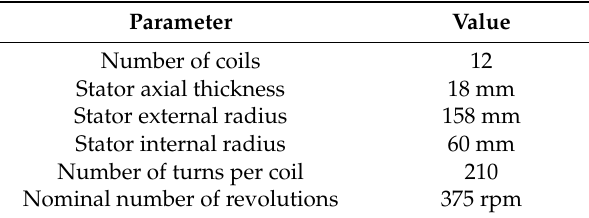
Table 2. Calculated variables from the theoretical